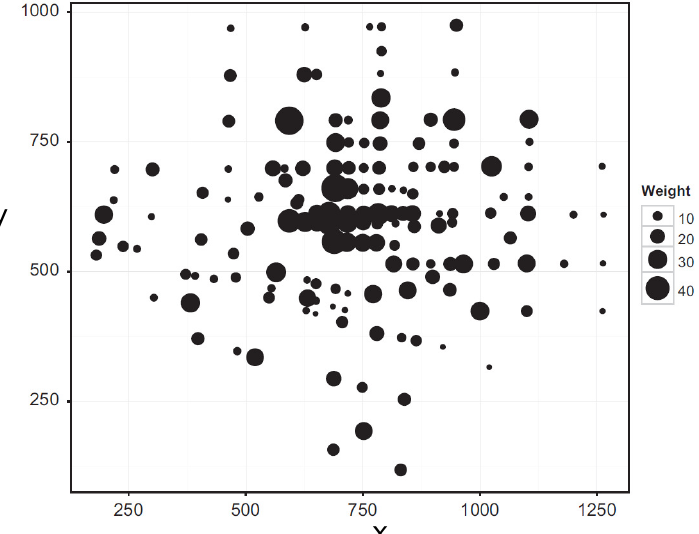
x Figure 2. London data set is one of the most used sets in the literature to represent problems with large instances of